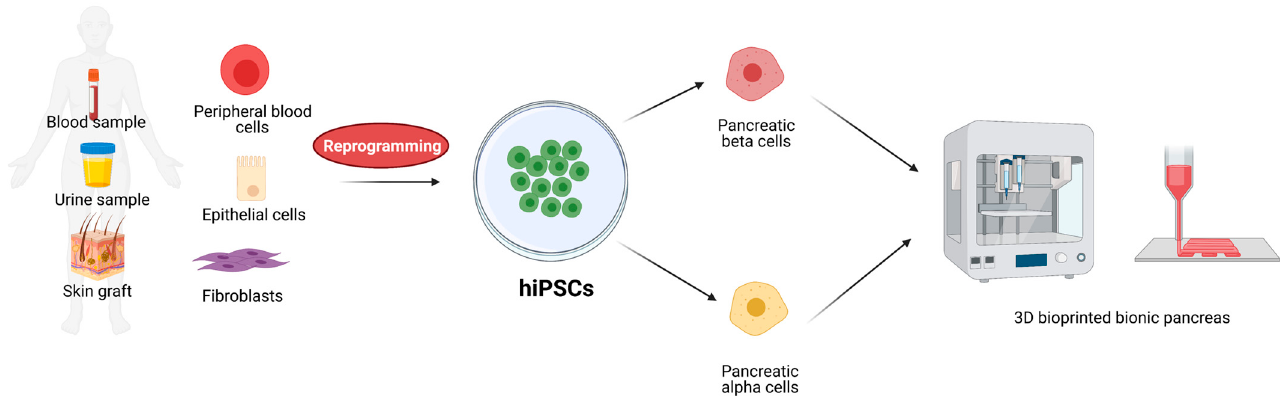
Figure 1. Schematic representation of iPSCs sources, possible differentiation, and application for 3D bioprinting of bionic pancreas. Created with BioRender.com accessed on 17 June